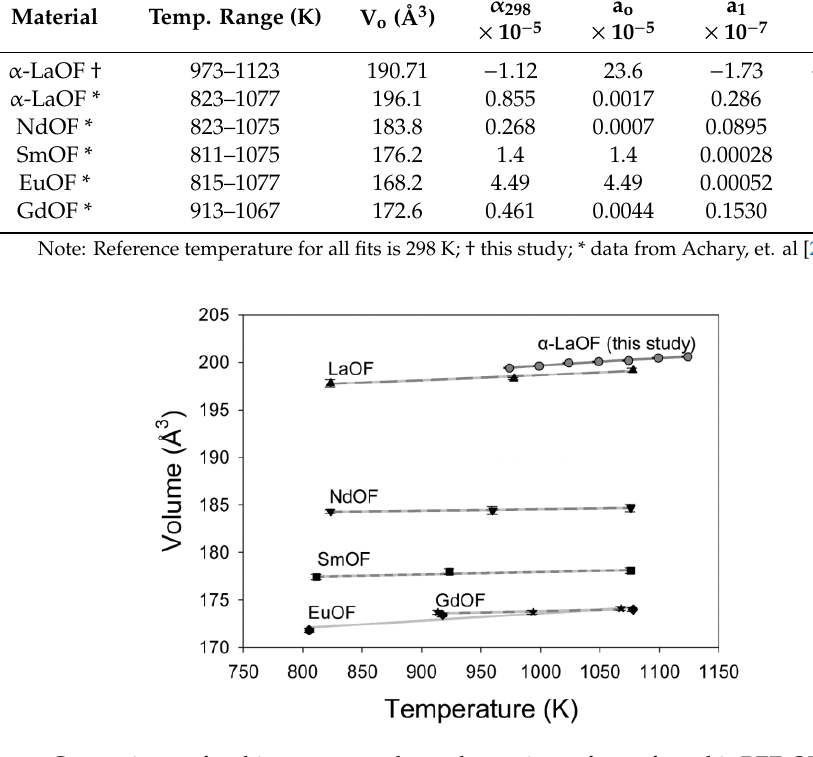
Figure 11. Comparisons of ambient pressure thermal equations of state for cubic REE-OF compounds from this study and using data from Achary et al. [24] (solid symbols). Gray circles are data for cubic α-LaOF from this study.